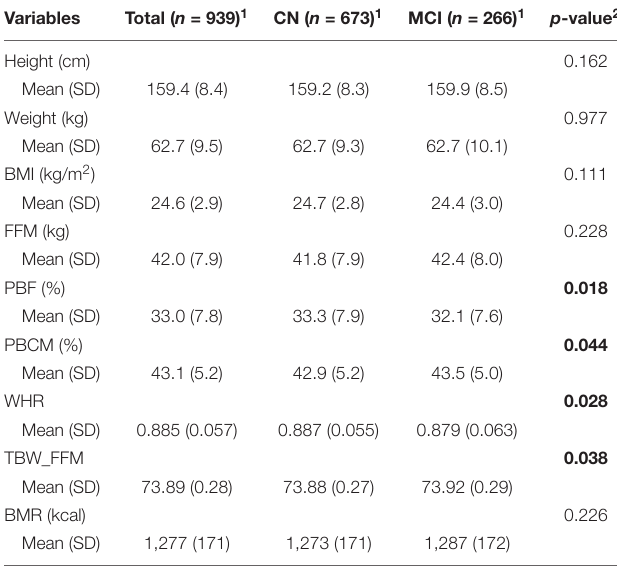
TABLE 2 | Anthropometry and whole-body composition